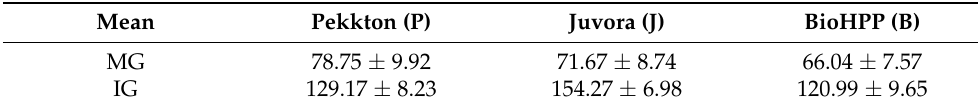
Table 3. Average values with standard deviation for MG and IG ( n = 8).